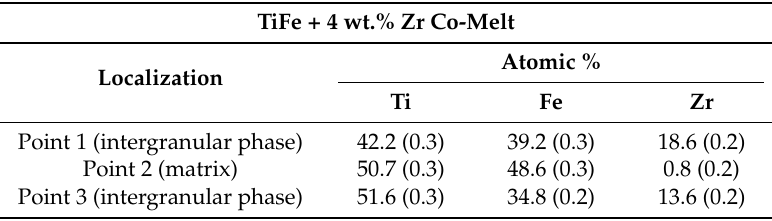
Figure 7. Secondary electron micrograph and EDX mapping of TiFe + 4 wt.% Zr co ‐ melt alloy. Numbers in the first image indicate specific points reported in Table 2. Table 2. Atomic abundance at specific points as measured by EDX of TiFe + 4 wt.% Zr co ‐ melt alloy. Error on each number is indicated in parentheses.